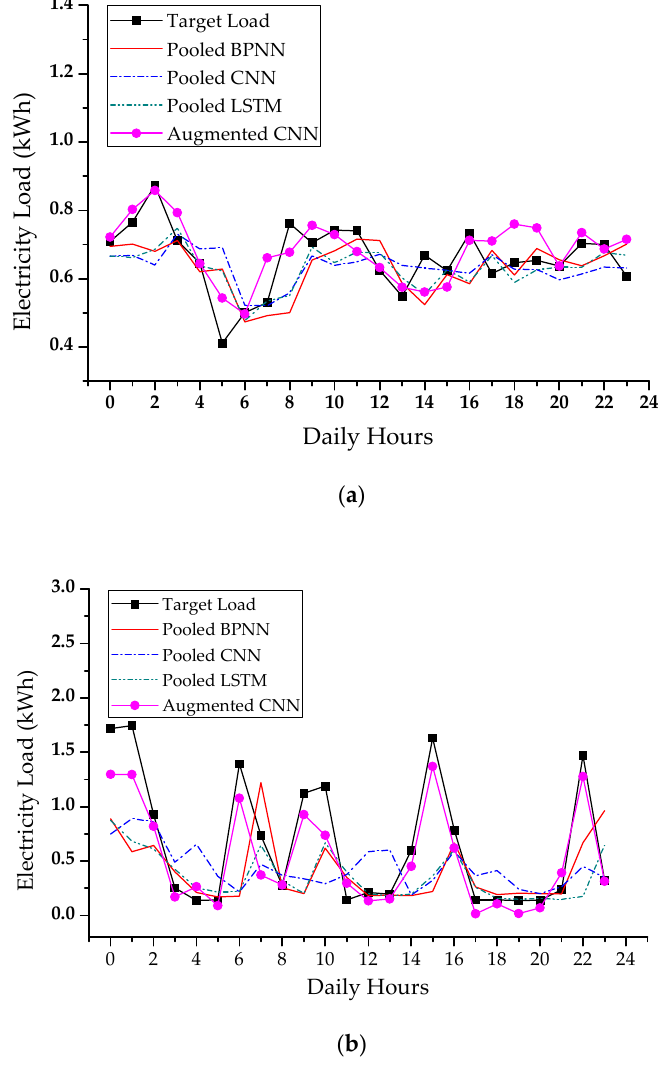
Figure 11. Day-ahead hourly load forecasting for the day of maximum energy consumption: ( a ) less uncertain household (household 4) and ( b ) highly uncertain household (household 10).